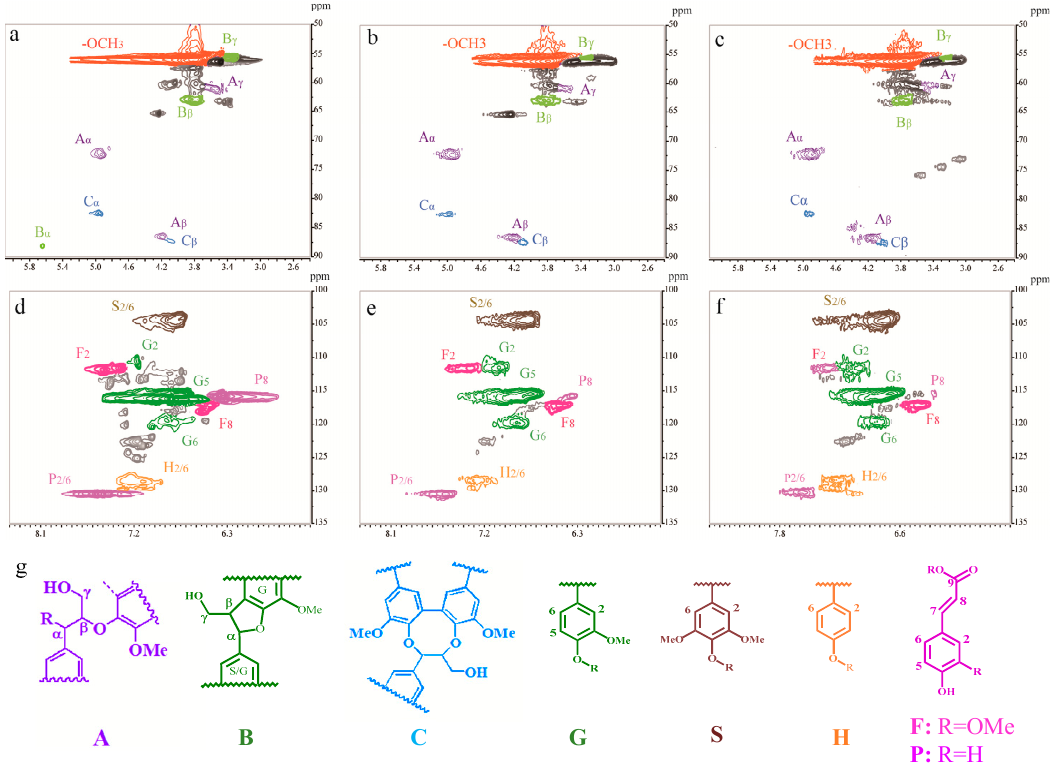
Side-chain ( a − c ) and aromatic regions ( d − f ) of 2D-NMR (HSQC) spectra of three lignin subdivisions (S1: a and d ; S2: b and e ; S3: c and f ). Main substructures identified: (A) β - O -4’ aryl ether linkage; (B) phenyl-coumaran structure formed by β -5’ and α - O -4’ linkages; (C) dibenzodioxocin structure; (G) guaiacyl unit; (S) syringyl unit; (H) p -hydroxyphenyl unit; (F) ferulic acid; (P) p -coumaric acid.